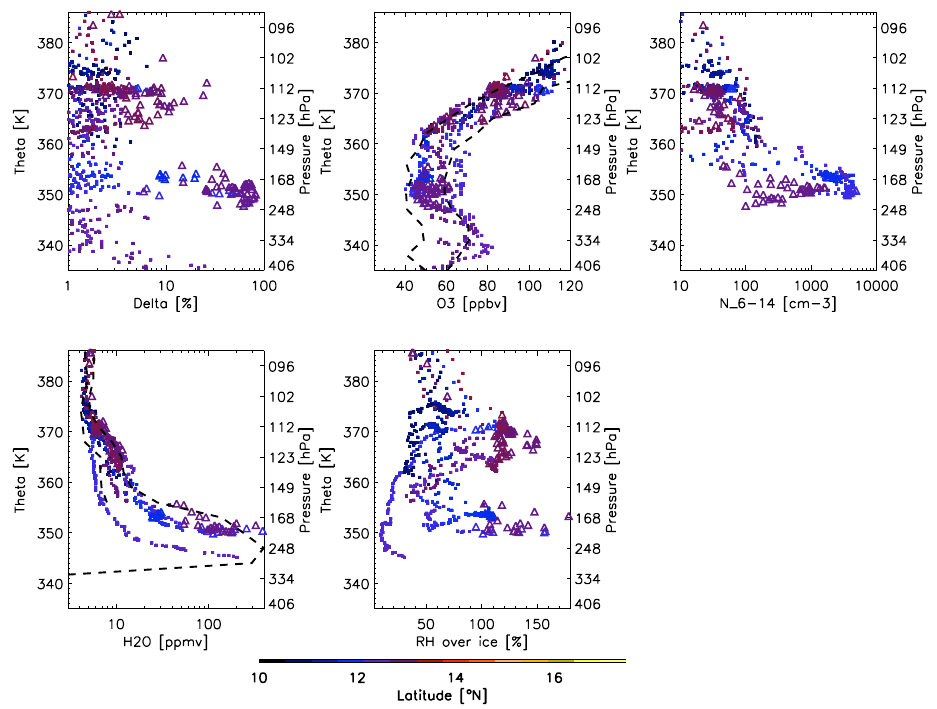
Fig. 2. Vertical profiles of observed depolarization δ a , ozone O 3 , carbon dioxide CO 2 , particle fine fraction N 6 -N 14 , water vapour H 2 O and relative humidity with respect to ice RH on 7 August 2006. Colors indicate the measurement latitude; triangles indicate the observations within air parcels containing aerosol (BSR > 1.2). Dashed lines indicate average values +/ − one standard deviation of O 3 , CO 2 and H 2 O.